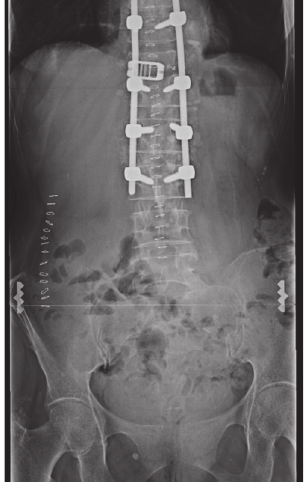
Figure 1: Initial iliac crest bone harvest procedure postoperative radiograph demonstrating relative position of incision with closure staples.